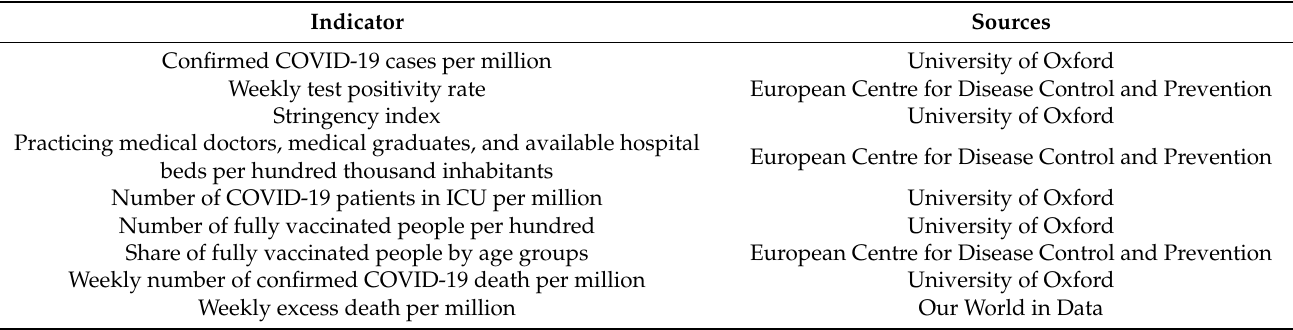
Table 1. Indicators used in the analysis and their